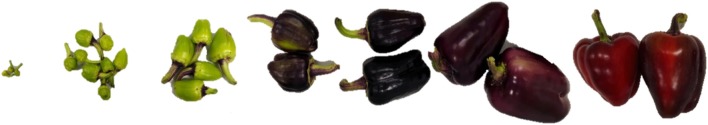
Anthocyanin accumulation and discoloration profile in pepper fruits of cv. Tequila during fruit development.